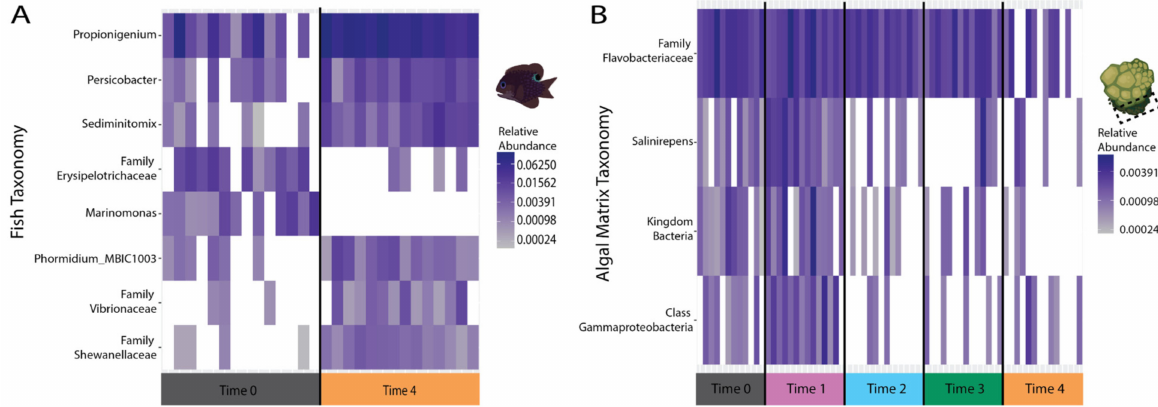
Figure 5. Fish and algal matrix bacterial taxa with significant changes in abundance. ( A ) Seven bacterial taxa ( Propionigenium, Persicobacter, Sediminitomix, Marinomonas, Phormidium_MBIC10003, Family Vibrionaceae, and Family Shewanellaceae ) within fish microbiomes changed significantly over time and one taxa (Family Erysipelotrichaceae ) changed significantly over time and the treatment*time interaction. ( B ) Four bacterial taxa (Family Flavobacteriaceae, Salinirepens, Kingdom Bacteria, and Class Gammaproteobacteria ) within algal matrix microbiomes changed significantly over time and the treatment*time interaction. Coral microbiomes did not have any taxa that significantly changed over treatment, time, or the interaction of these variables. If not identified to genus, the next higher classification taxonomic assignment is used. Darker colors indicate higher abundance, and no color indicates an absence of that